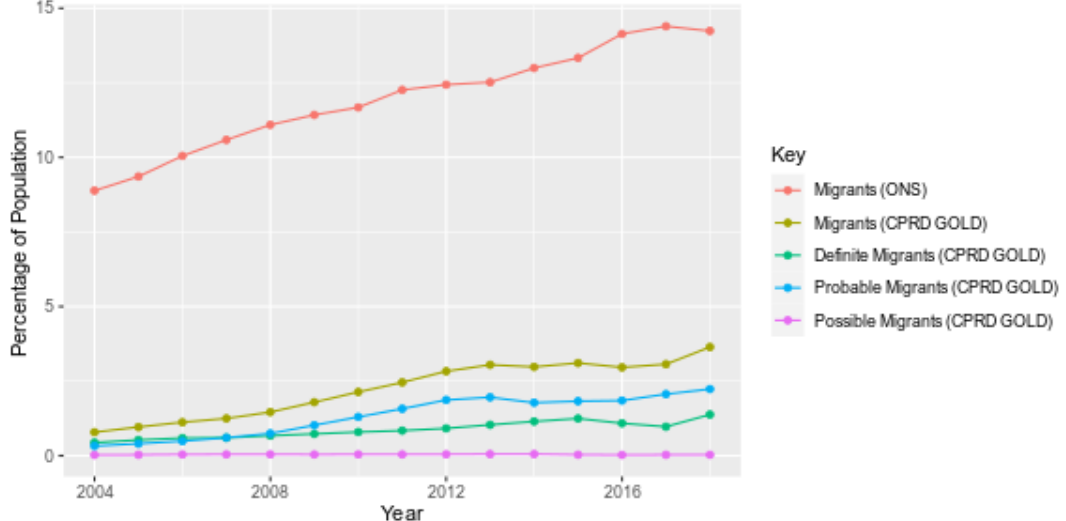
Figure 3. Percentage of international migrants in CPRD and international migrants in ONS by certainty of migration status (2004 – 2018).